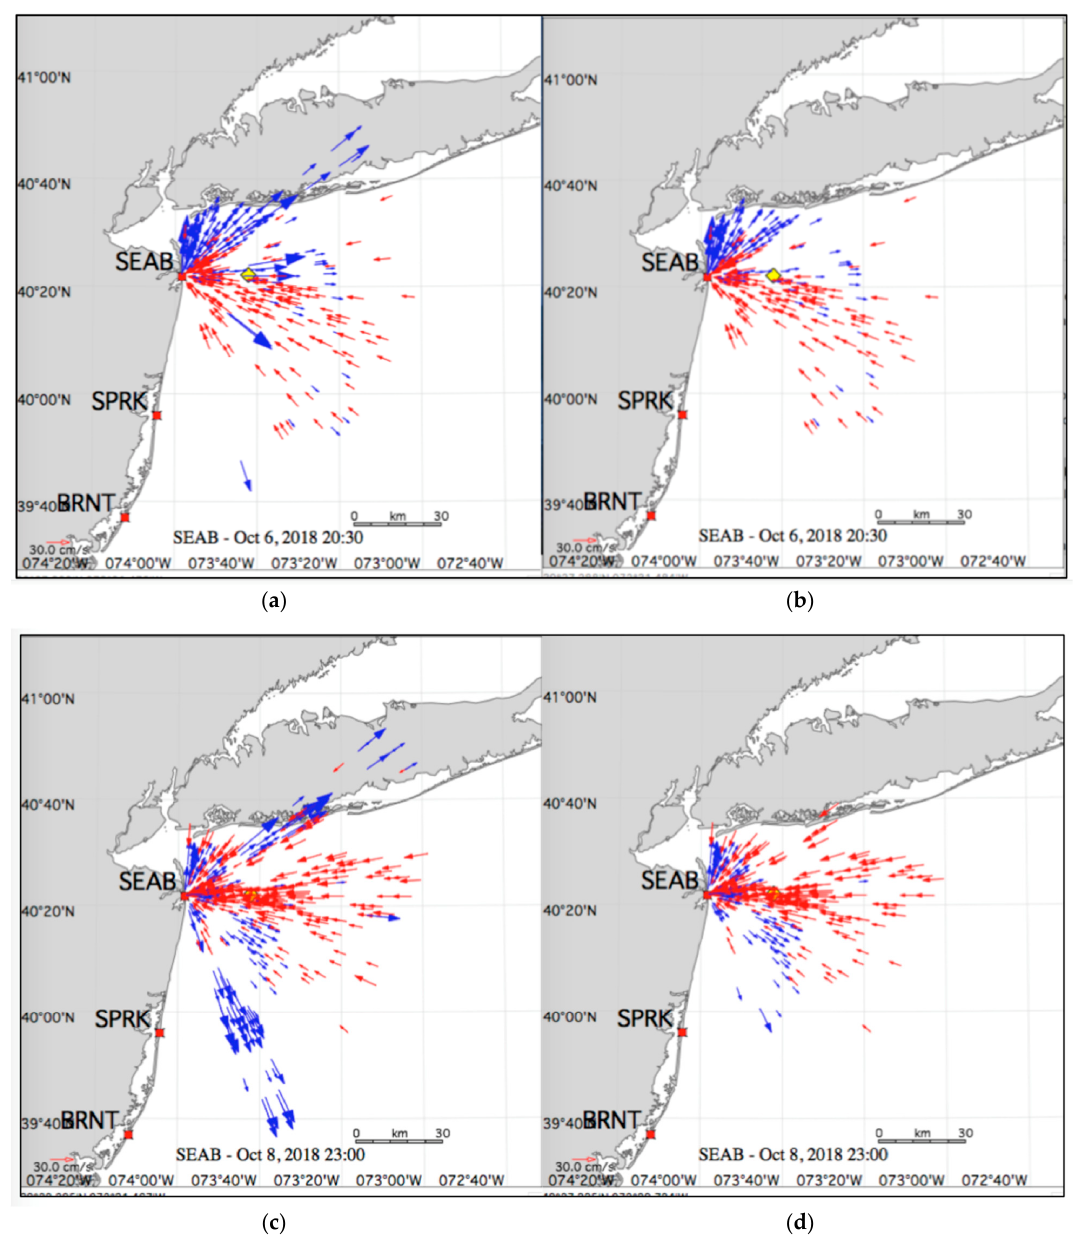
Figure 8. Comparison of current velocity maps obtained with and without QC at Sea Bright, New Jersey. Radar transmit frequency 13.5 MHz. The threshold S lim was set to 1.4. 6 October, 2018, 20:30, 6:00 a.m.: ( a ) without QC, RMS av = 2.9 ( b ) with QC, RMS av = 0.48. 8 October, 2018, 11:00 p.m.: ( c ) without QC RMS av = 3.2 ( d ) with QC RMS av = 0.49.